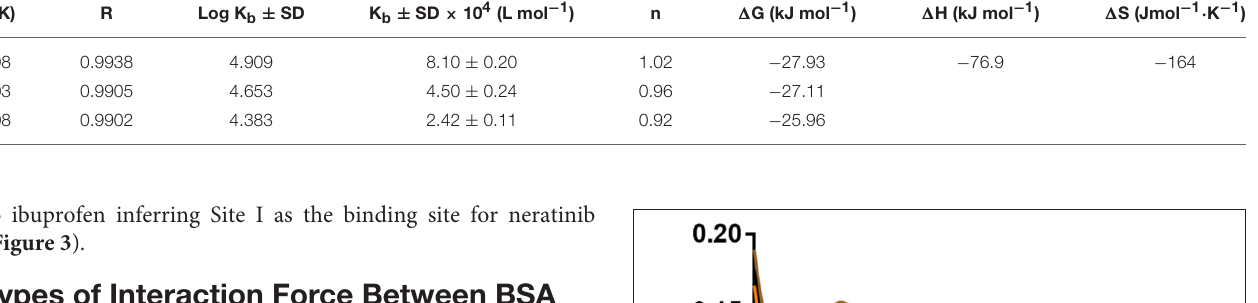
TABLE 2 | Binding and thermodynamic parameters of binding between neratinib and BSA. T(K)